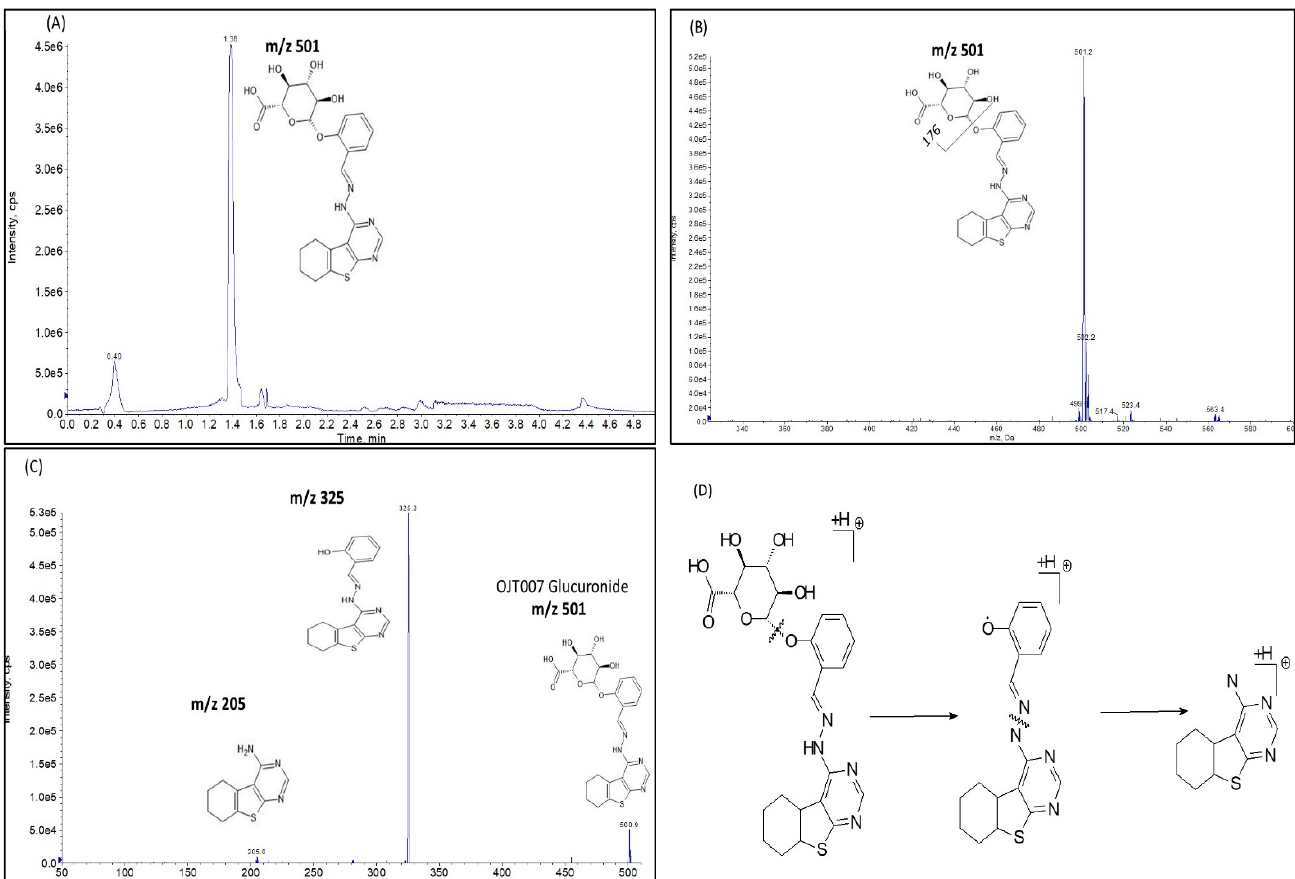
Figure 8. ( A ) Representative Q1MI chromatogram, OJT007 Glucuronide retention time 1.38 min. ( B ) Neutral loss scan of 176 Da spectra. ( C ) Product ion scan spectra m/z 501. ( D ) Fragmentation pattern for OJT007 glucuronide.